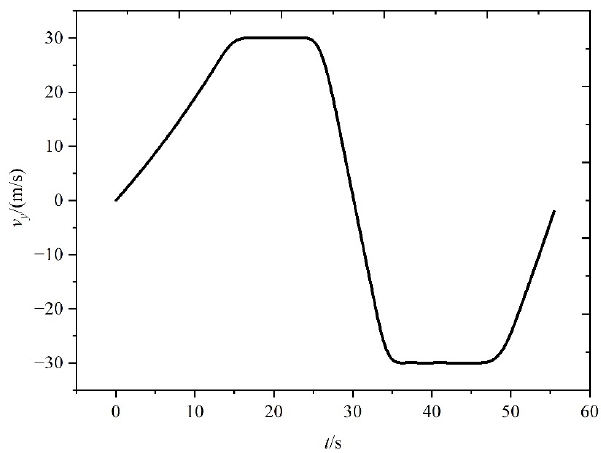
Figure 5. Vertical velocity for the first scenario vs. time.